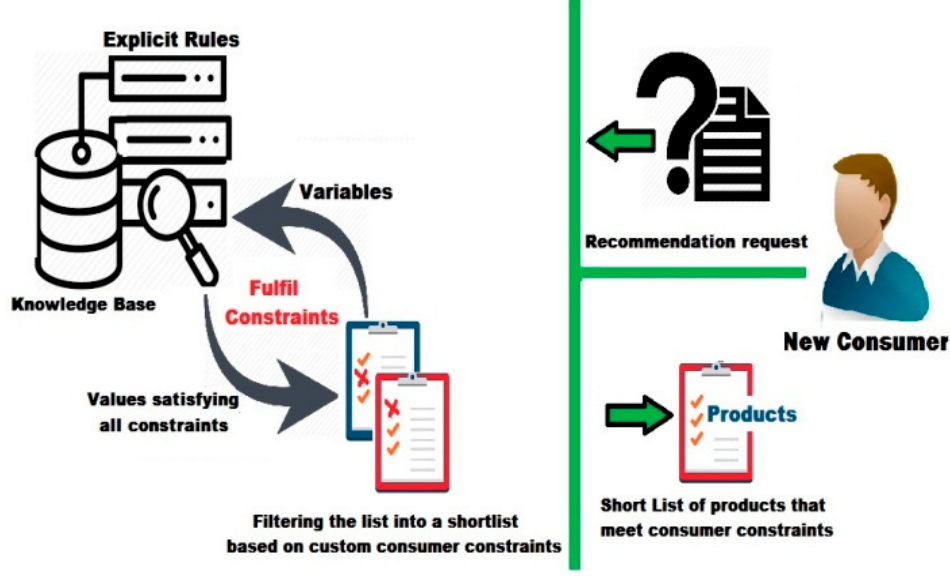
Figure 9. Filtering based on consumer’s constraints.